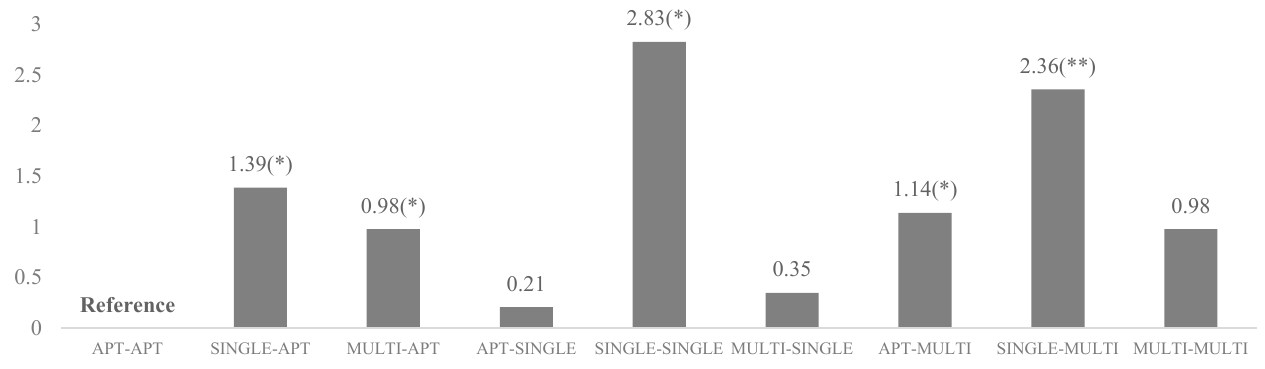
Figure 5. Interaction effect (odds ratio) in MLIM with reference to APT-APT. Note: **, * denote rejection of the hypothesis at the 0.05 (5%) and 0.1 (10%) levels,